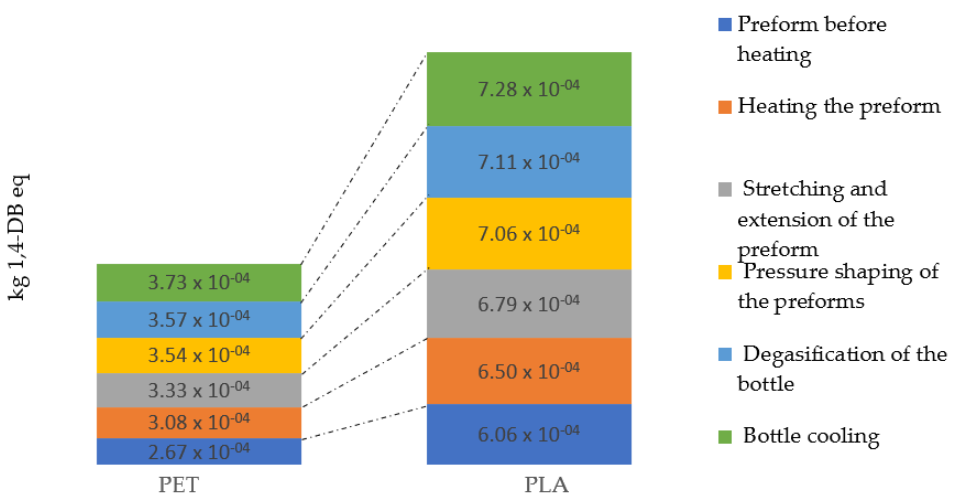
Figure 12. Terrestrial ecotoxicity emissions throughout the entire bottle shaping process. In the case of impact category, photochemical oxidation, similar values of potential environmental impacts were observed. However, the greatest impact on the reduction of environmental quality caused by photochemical oxidation is characteristic for the cycle of PET bottle formation (3.40 × 10 −5 kg C 2 H 4 eq). The process of creating a PLA bottle (3.12 × 10 − 5 kg C 2 H 4 eq) stands out with the lowest level of negative influences under this impact category (Figure 13).